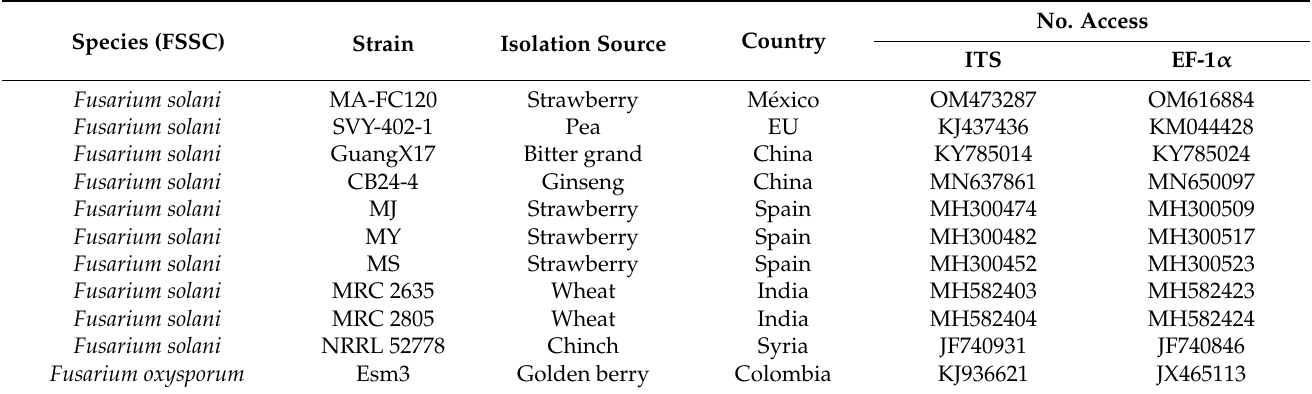
Table 1. Fusarium solani species complex gene (FSSC) bank sequences to corroborate the identity of strain MA-FC120.